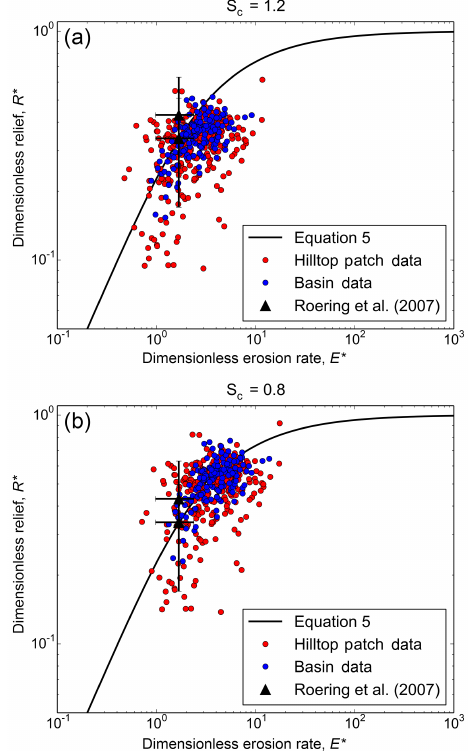
Figure 3. Hilltop patch and basin average data for Gabilan Mesa plotted using a critical gradient of 1.2 (a) and 0.8 (b) alongside data from Roering et al. (2007) for the same location. Error bars are the standard error.